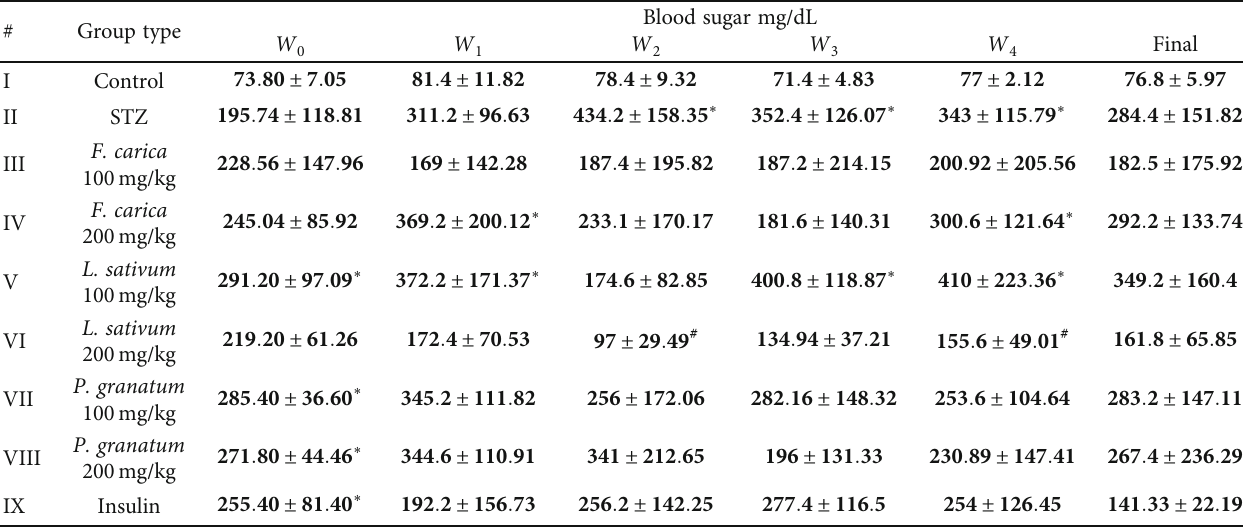
Table 3: E ff ect of di ff erent Lepidium sativum , Ficus carica , and Punica granatum methanolic extracts on 5-week blood glucose, in STZ- induced diabetic rats.